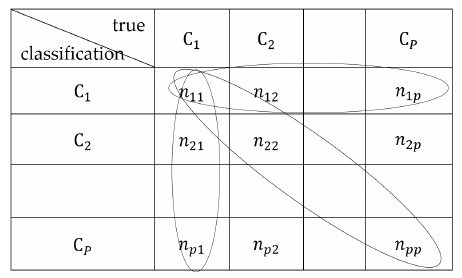
Figure 10. P -class confusion matrix.